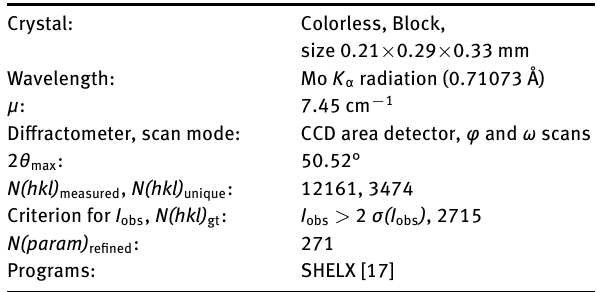
Table 2: Fractional atomic coordinates and isotropic or equivalent isotropic displacement parameters (Å 2